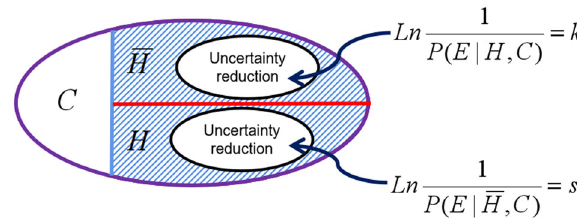
Fig. 2 Feature-matching identi fi cation value. The feature-matching identi fi cation value for hypothesis is de fi ned by the feature-matching likelihood of opposite hypothesis. Ln 1 P ð E j H ; C Þ reduce the uncertainty of (cid:1) H , and Ln 1 reduce the uncertainty of H . H and (cid:1) H are unknown for the forensic P ð E j (cid:1) H ; C Þ